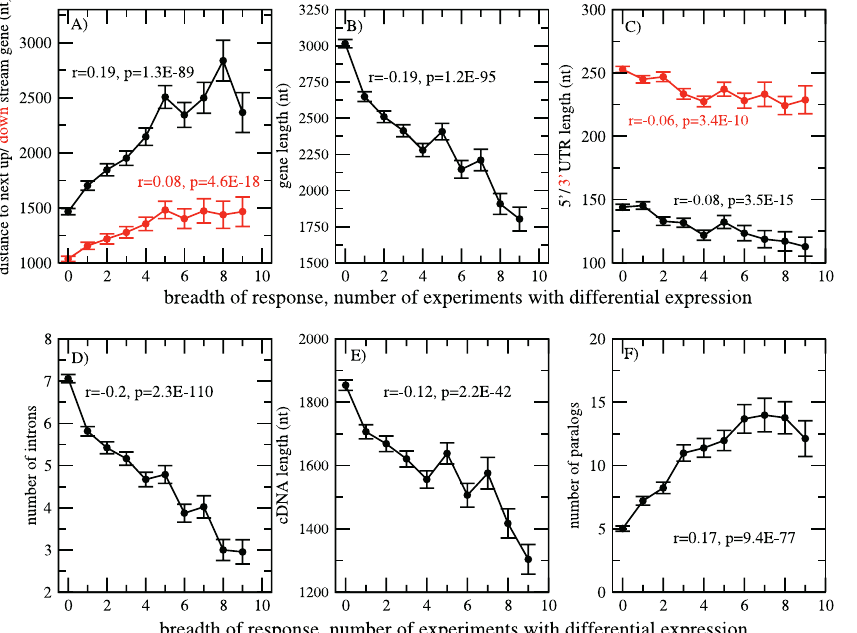
Figure 4. Correlation of the Length of Intergenic Upstream and Downstream Sequence (Distance to the Next 5 9 -Upstream Gene), Gene Length, 5 9 /3 9 UTR Length, Number of Introns, cDNA Length, and Number of Paralogs with the Breadth of Differential Gene Expression Response (A) Intergenic upstream and downstream sequence (distance to the next 5 9 -upstream gene). (B) Gene length. (C) 5 9 /3 9 UTR length. (D) Number of introns. (E) cDNA length. (F) Number of paralogs with the breadth of differential gene expression response. Plotted data points correspond to mean values and associated standard errors of the mean. Pearson linear correlation coefficients, r , and associated p - values are given for all raw data